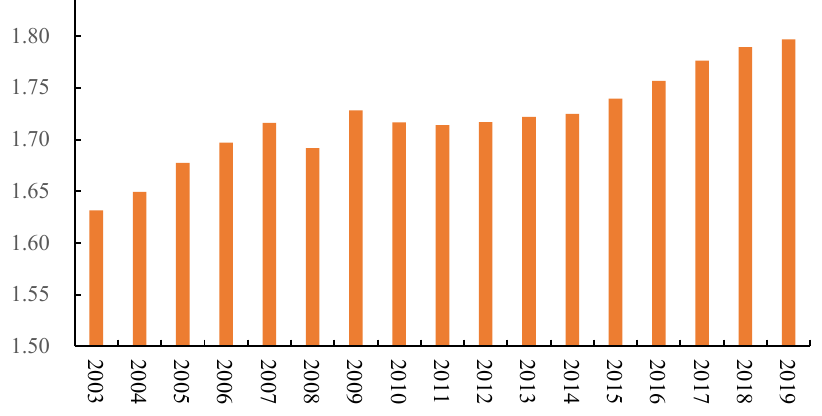
Figure 2. Upgrading level of China’s fishery industrial structure from 2003 to 2019.